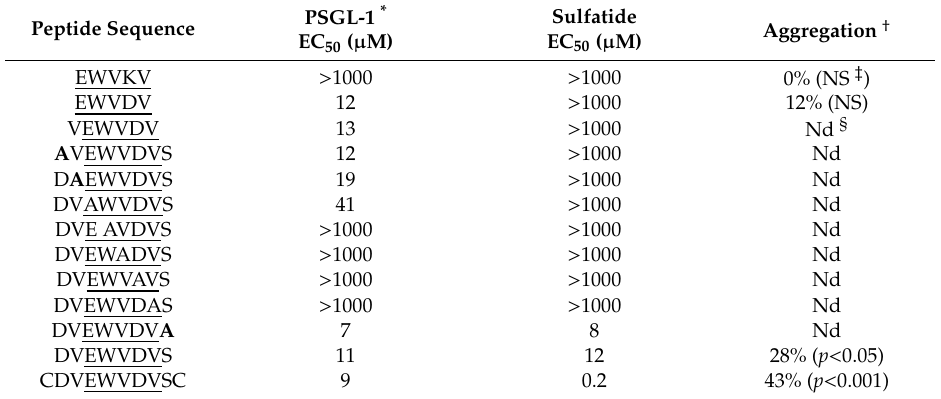
Table 1. The ability of EWVDV motif-containing peptides to displace P-selectin binding to HL60 cells (PSGL-1 (P-selectin Glycoprotein Ligand-1)) and sulfatide liposomes (Sf28) and to attenuate platelet